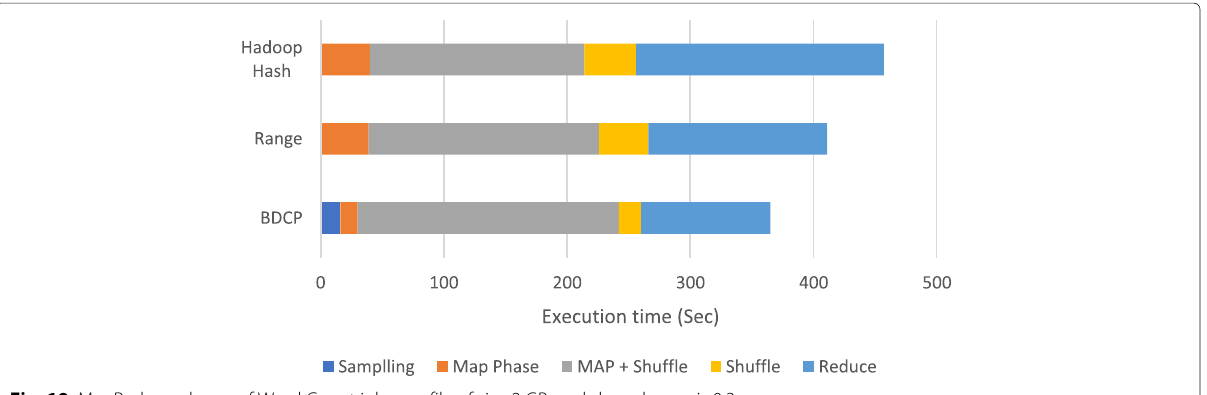
Fig. 19 MapReduce phases of Word Count job on a file of size 2 GB, and skew degree is